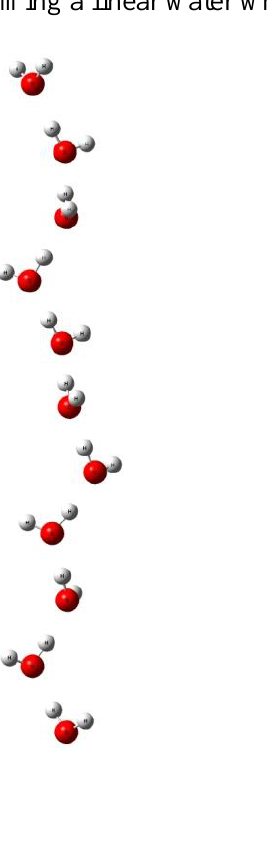
Figure 8. Cluster of 11 water molecules forming a linear water whisker in a field F = 0.5